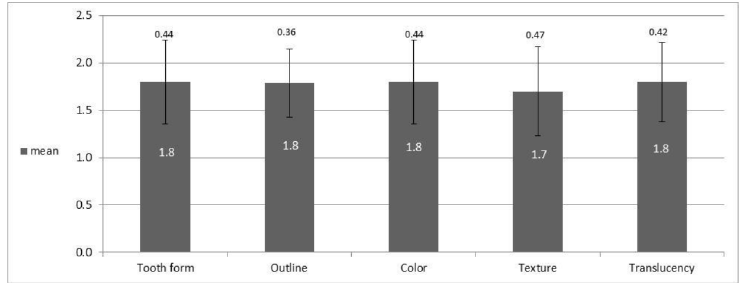
Figure 2. Mean WES value of each parameter indicating a good white esthetic